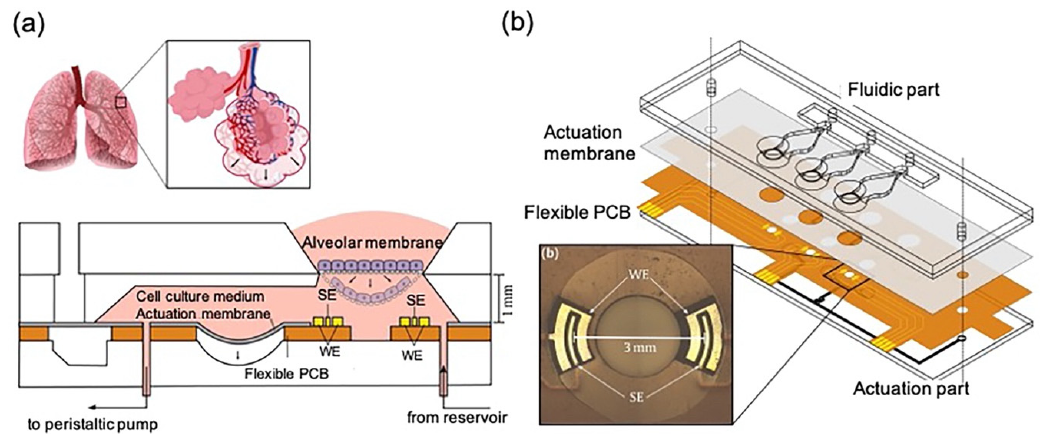
Figure 5. LOC integrated with a MITO system: ( a ) Cross-sectional view of the system. ( b ) Detailed information about the flexible PCB that can be bonded between two layers in the LOC. Reproduced with permission from [55] .